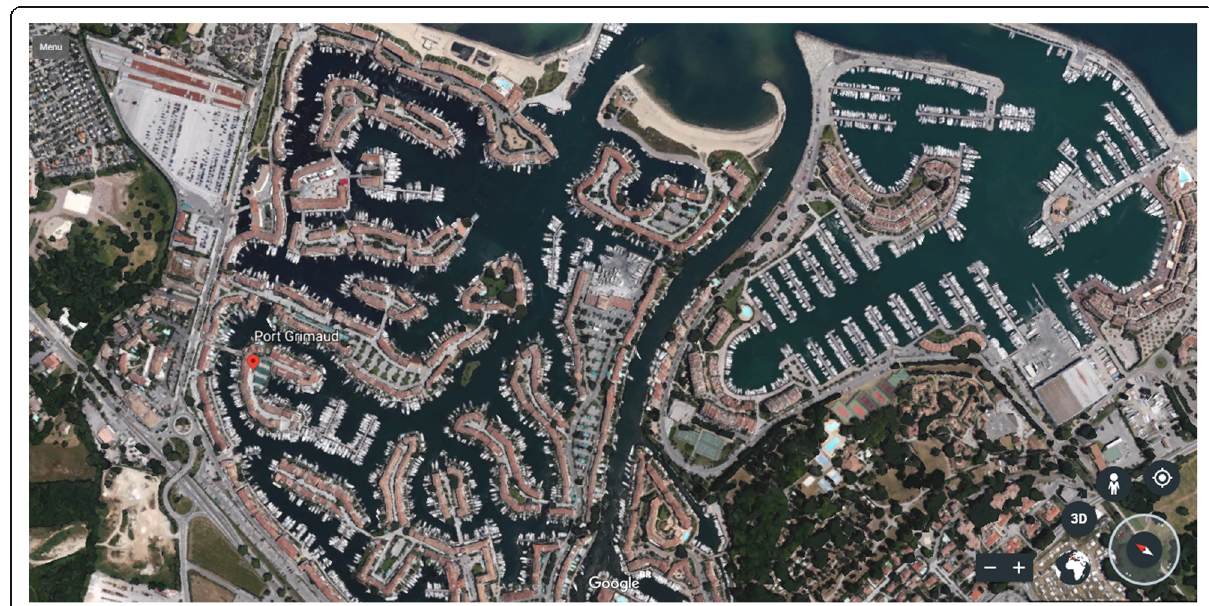
Fig. 5 Aerial view of Port-Grimaud, France. Google Earth: 43°16 ′ 08.0 ″ N 6°34 ′ 55.3 ″ E (https://www.google.com/earth/). The village was projected by François Spoerry to provide the best disposition where every docked boat would have direct access to mainland. It serves as an analogy to how the papillary architecture in the bladder is a non-physiological organization that optimizes the dynamics of proliferated lamina propria and urothelial cells